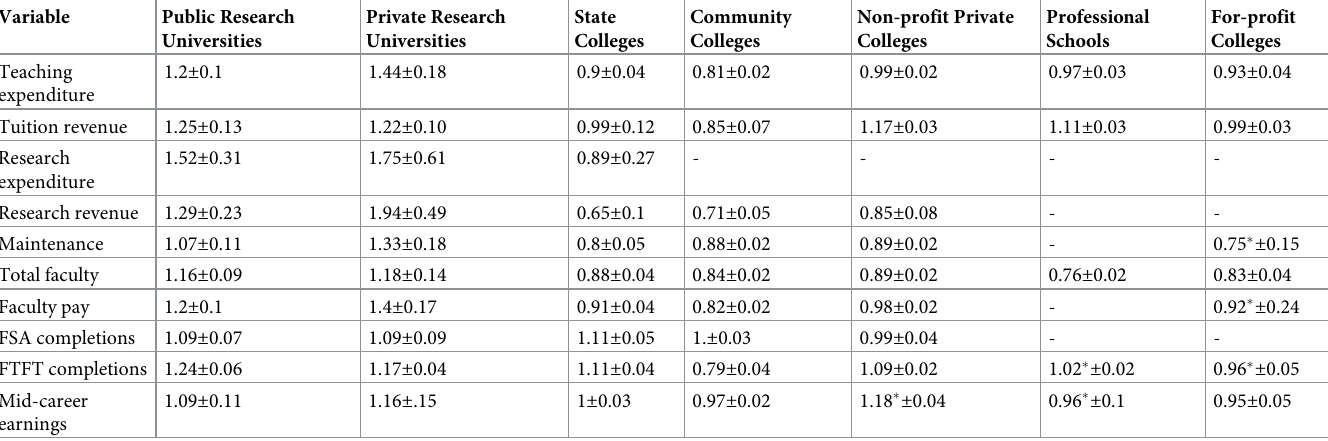
Table 2. Summary of scaling